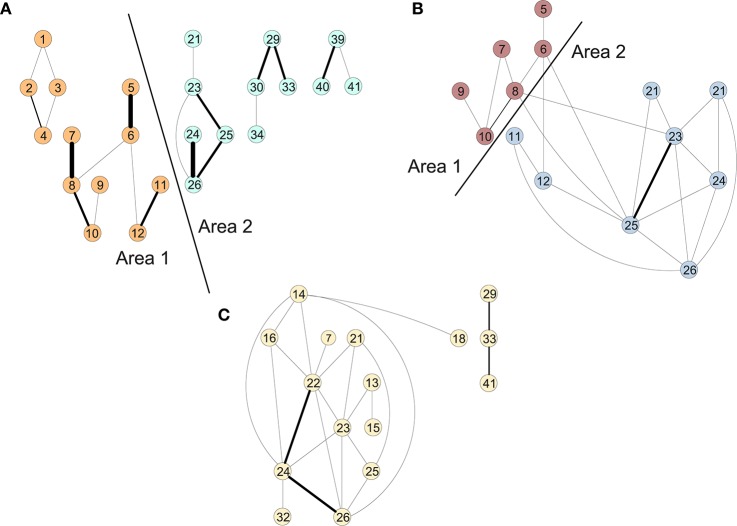
Areas of the connectivity graph for functional data for (A) controls, (B) MCI, and (C) AD.